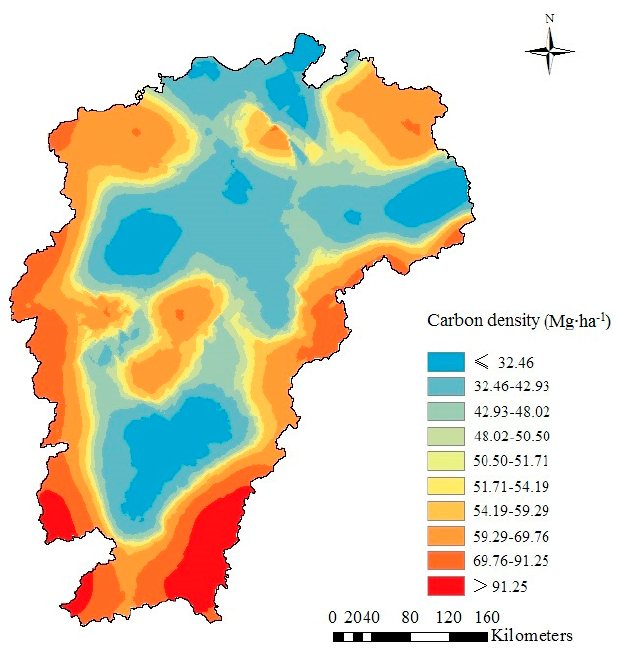
Figure 7. Spatial interpolation graph of vegetation carbon density (including tree, understory vegetation and litter layers) in Pinus massoniana forest in the Jiangxi Province.